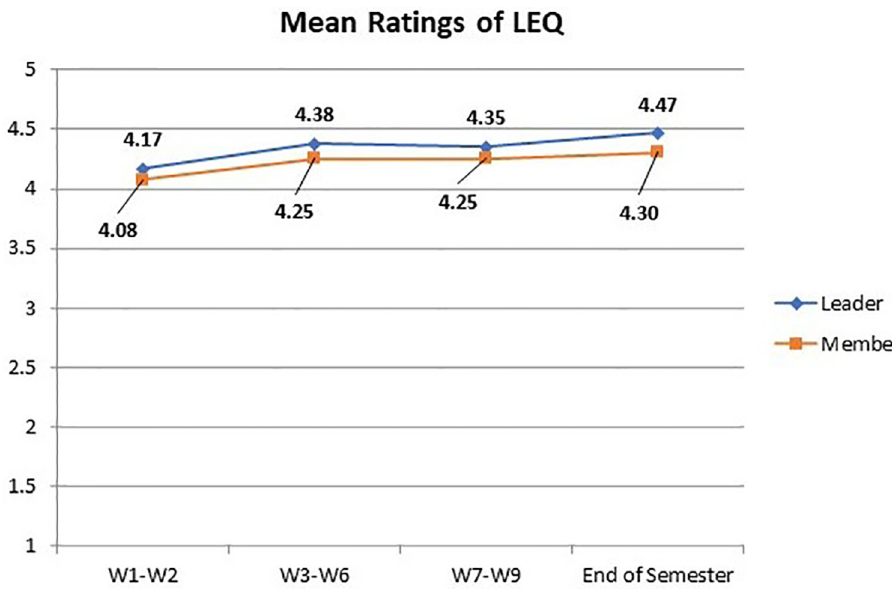
Fig 5. Mean LEQ ratings for leaders and members during the